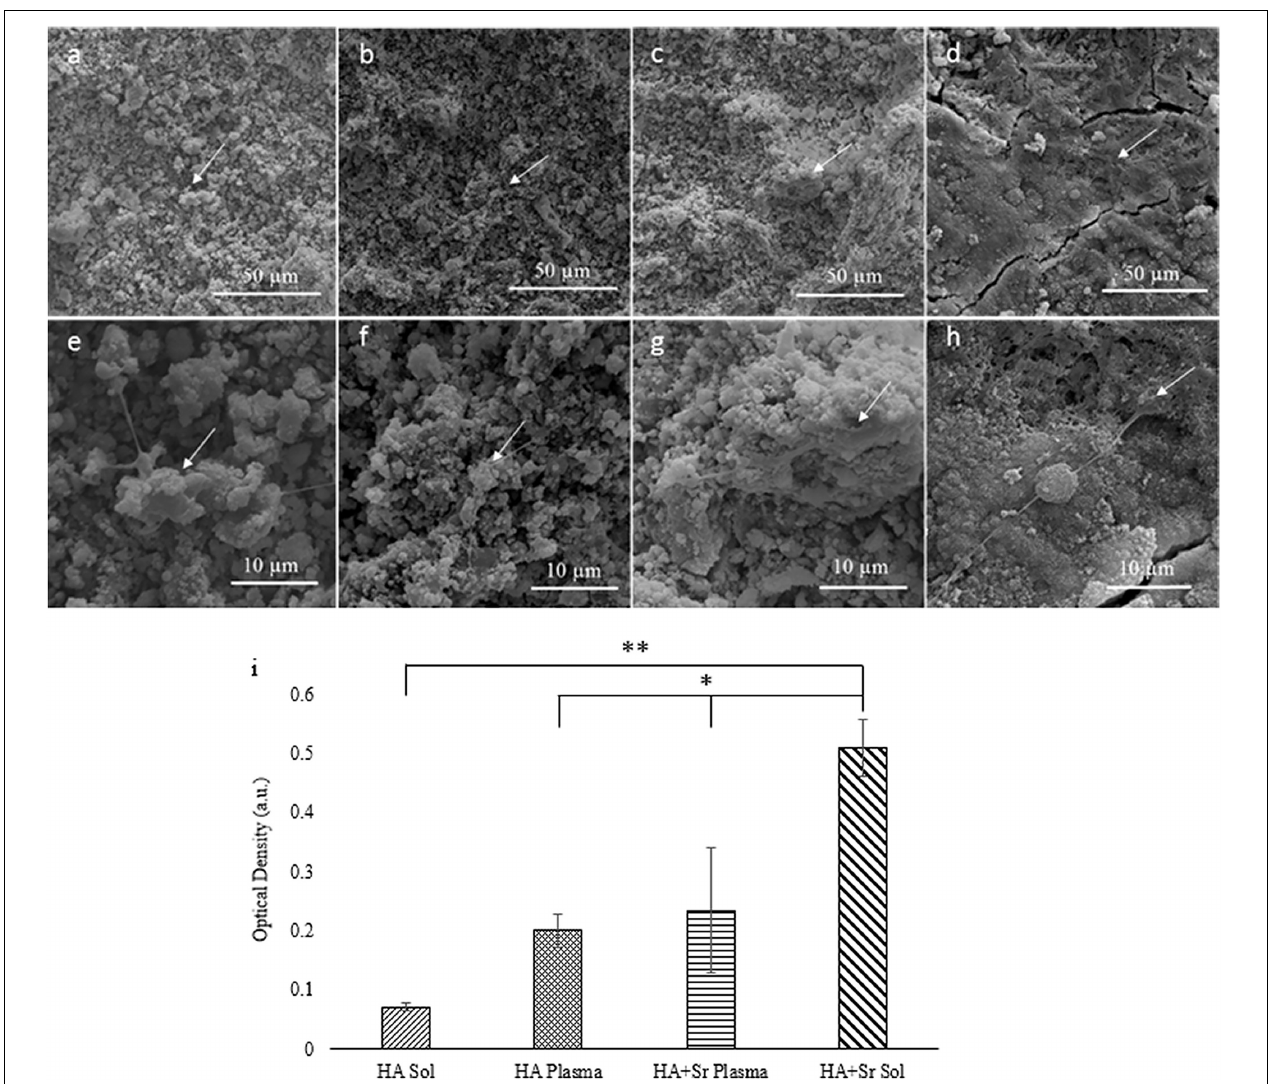
FIGURE 6 | SEM images of plasma sprayed HA and Sr-HA (a,b) , and sol-gel coated HA and Sr-HA (c,d) at day 3 timepoint. Higher magnification of the area shown below for each respective coating (e–h) . MTT data (i) for OB cultures on plasma and sol-gel coated HA and Sr-HA samples for the day 3 timepoint (* p < 0.05, ** p < 0.01, N = 3) (Robertson et al.,